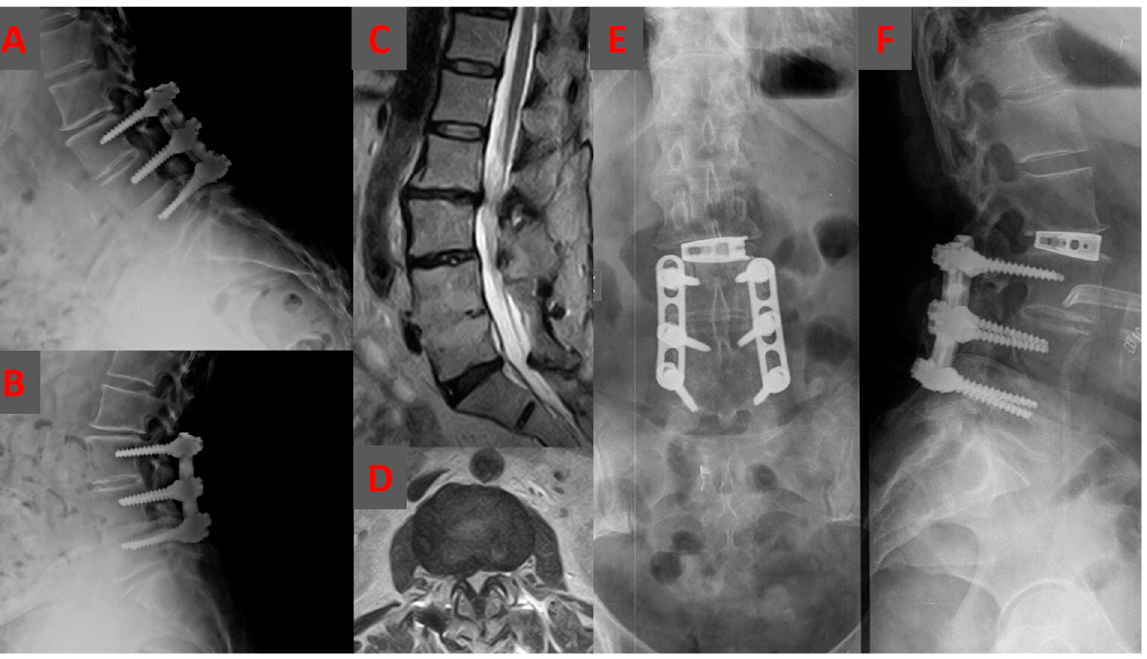
Figure 2. An illustrative case showing a preoperative dynamic lateral lumbar radiograph of a 72-year- old woman following a posterior L3–L5 fusion and a disc degeneration, and retrolisthesis present at L2–L3 ( A , B ). A T2-weighted sagittal ( C ) and axial ( D ) MRI scan confirming the disc degeneration and showing a right foraminal stenosis. Anterior ( E ) and lateral ( F ) radiograph showing the stand-alone oblique lumbar interbody fusion at L2–L3 with cage